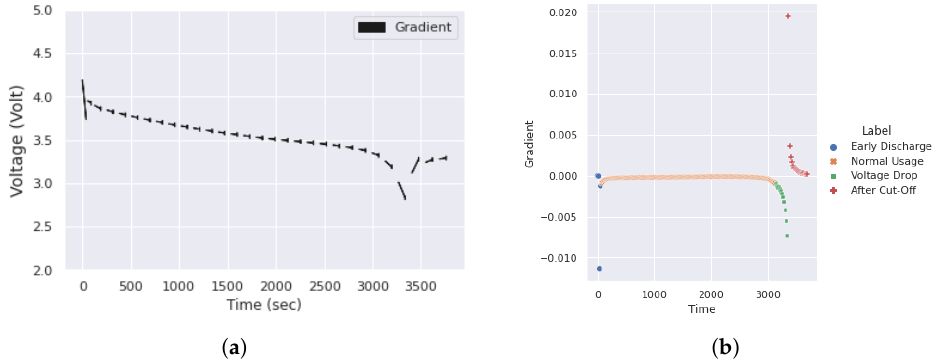
Figure 6. Fresh cell of BAT0005. ( a ) Vectors’ position at the curve. ( b ) Gradient value over